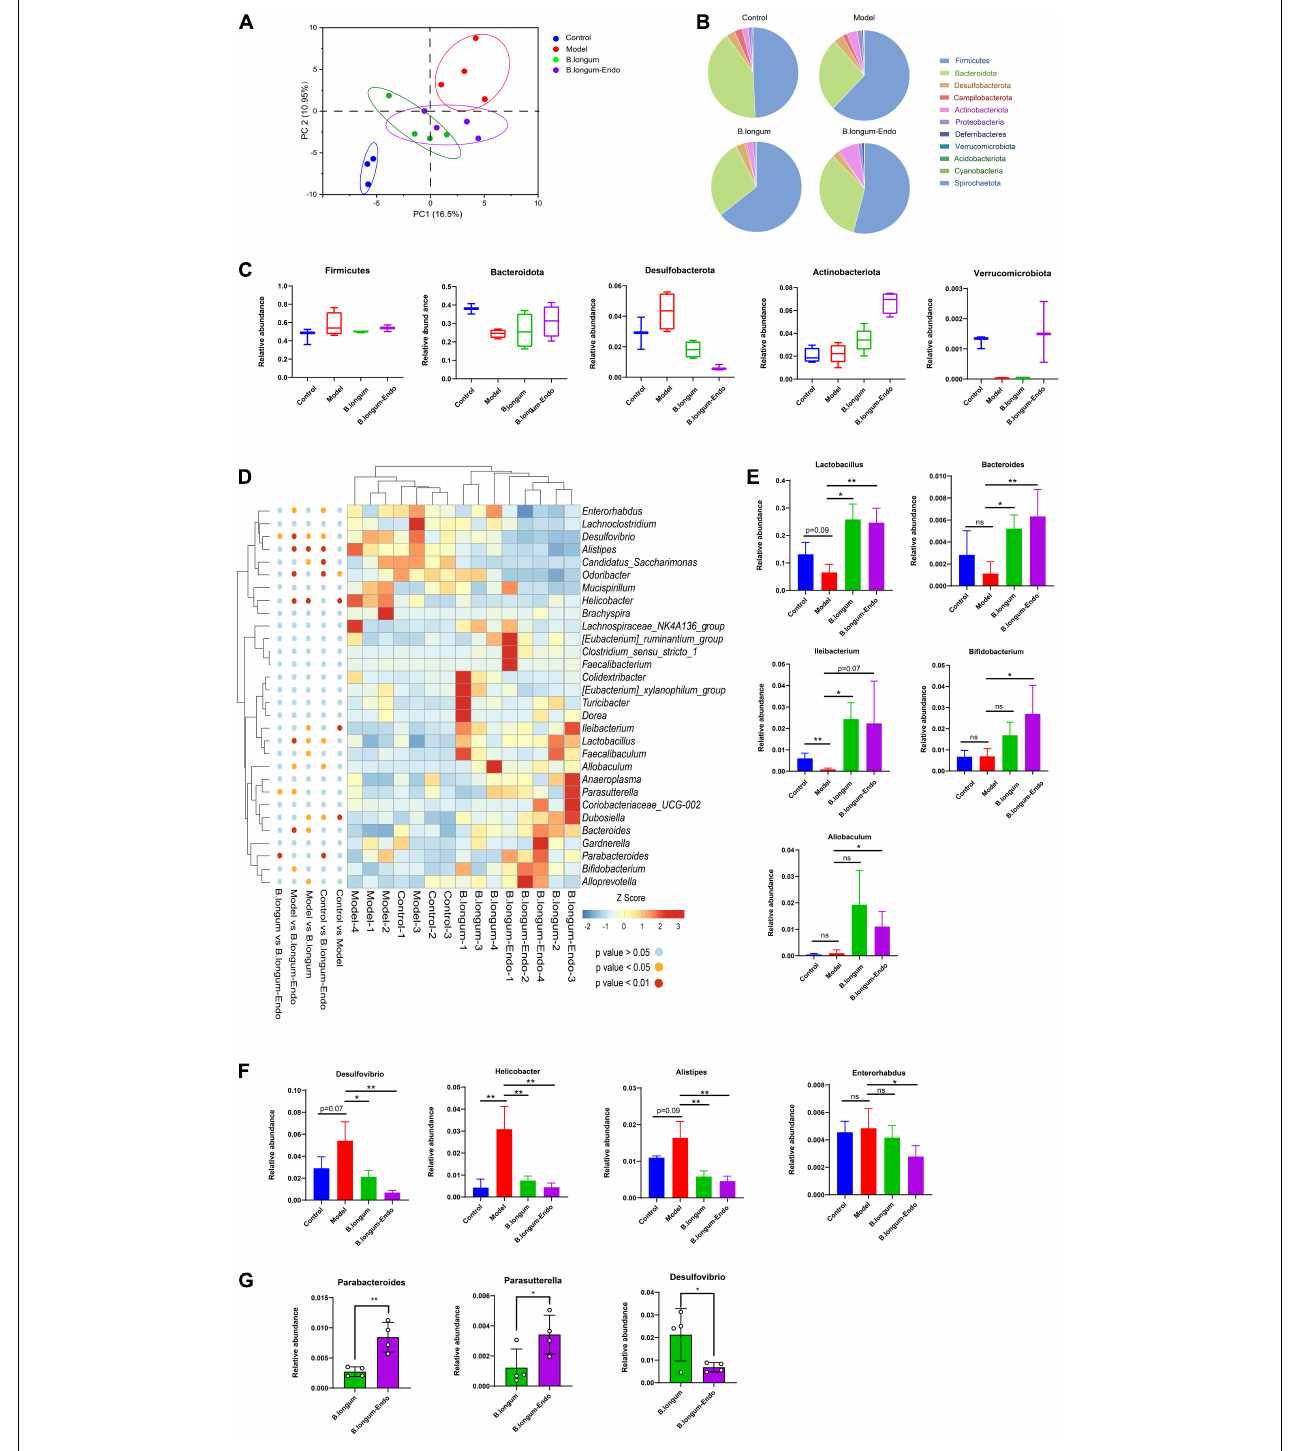
FIGURE 5 | B. longum-Endo improved intestinal flora dysbiosis caused by AOM/DSS. (A) Principal components analysis (PCA). (B) Overview of relative abundance of microbiota at phylum level in mice. (C) The relative abundance changes of Firmicutes , Bacteroidota , Desulfobacterota , Actinobacteria , and Verrucomicrobiota after B. longum-Endo treatment. (D) Heatmap depicting the relative abundance of bacterial species at genus level for each mouse. (E) Relative abundance of representative beneficial bacteria ( Lactobacillus , Bacteroides , Ileibacterium Bifidobacterium , and Allobaculum ). (F) Relative abundance of representative harmful bacteria ( Desulfovibrio , Helicobacter , Alistipes , and Enterorhabdus ). (G) Representative differential microbiota ( B. longum-Endo group vs. B. longum group, P < 0.05). * P < 0.05; ** P < 0.01; ns: not significant.